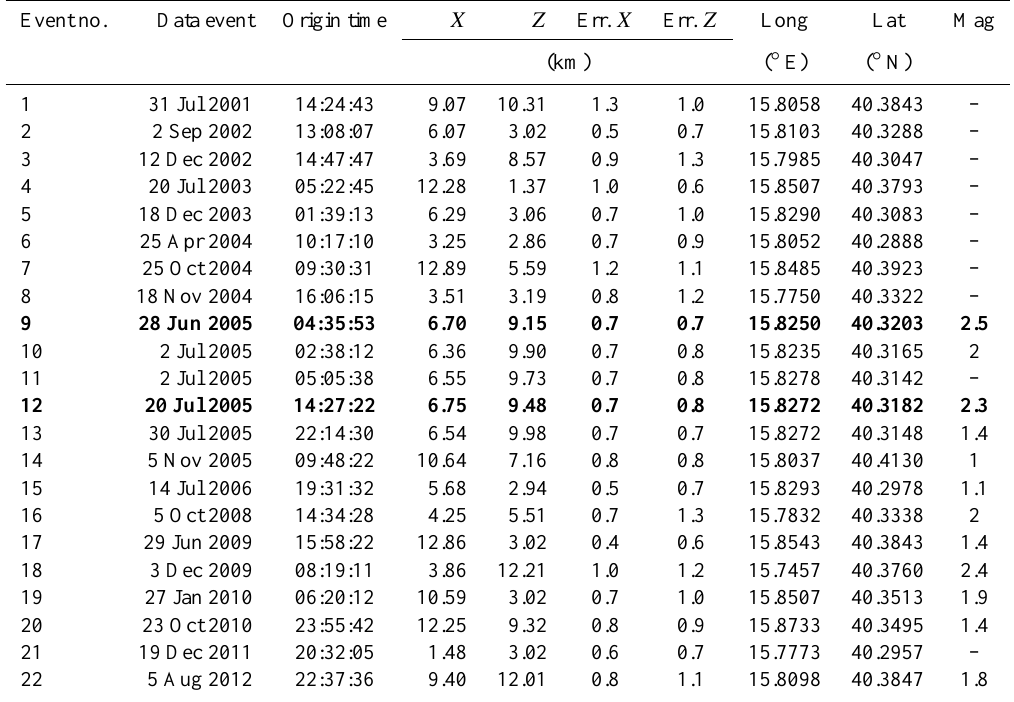
Table 1. Events selected in this study. Focal mechanism has been computed for events highlighted in bold. The magnitude estimation has been retrieved from INGV catalogues, when available. Event no.